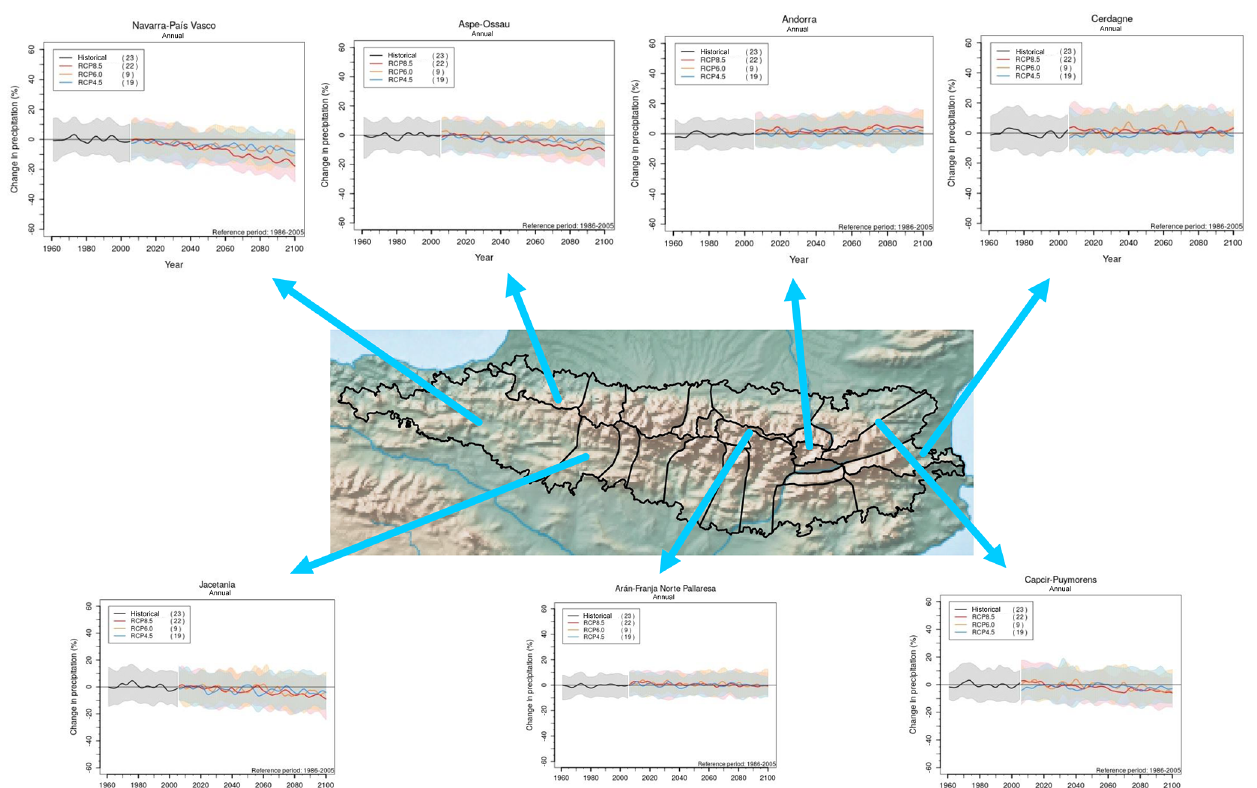
Figure 12. The same as Fig. 7 but for relative anomaly of accumulated precipitation (%). A 10-point Gaussian filter has been applied.